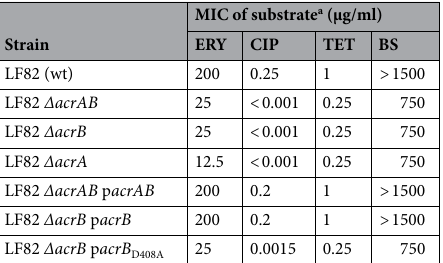
Table 1. MICs of AcrAB substrates for LF82 and acrA , acrB or both and complementary strains. a